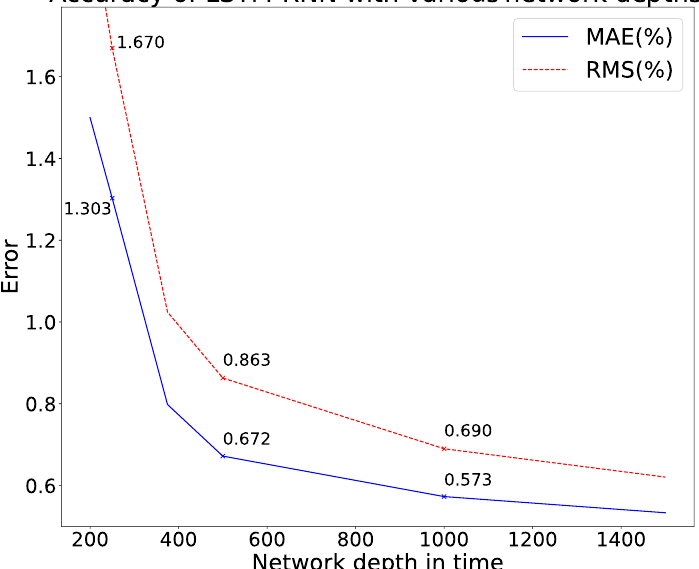
Figure 5. SoC estimation accuracy of LSTM-RNN with various network depths in time obtained by Chemali et al. [11] in a plot